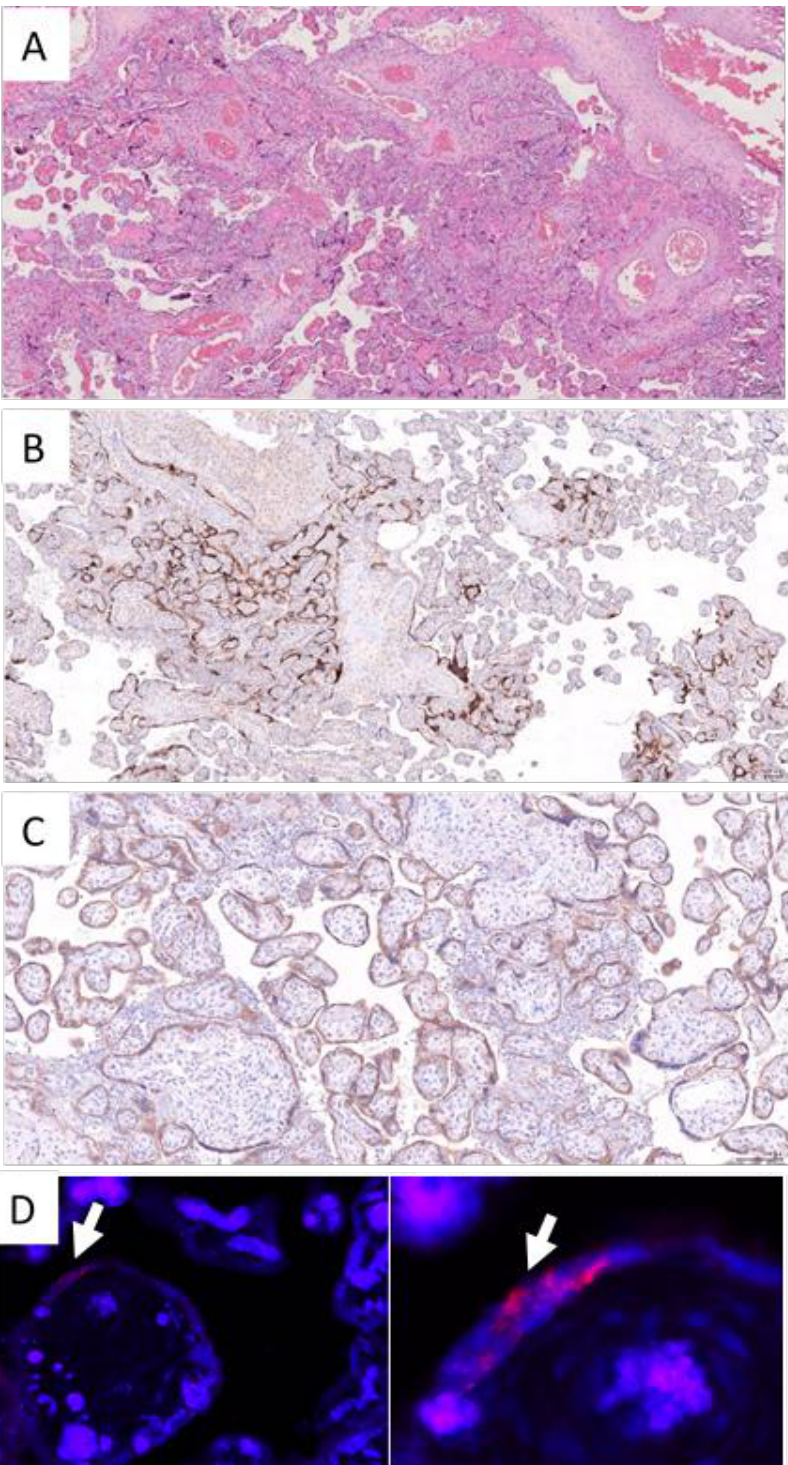
Figure 1. Placental examination—case 1. ( A ) Foci of chronic intervillositis with massive peri-villous fibrin deposition and early placental infarction (hematoxylin and eosin, original magnification ×4). ( B ) Strong cytoplasmic positivity of villous trophoblastic cells with SARS-CoV-2 spike antibody co-localized with the foci of chronic intervillous inflammation (hematoxylin and eosin, original magnification × 4). The following antibodies were used: CD68-PGM1 (Dako Monoclonal Mouse Anti- Human CD68, Clone PG-M1, dilution 1/200), ACE2 (Atlas antibodies, clone CL4035, dilution 1/1000), and SARS-CoV-2 spike antibody (Sino Biological, SARS-CoV Spike S1 Subunit Antibody, Rabbit PAb, Antigen Affinity Purified, dilution 1/250). ( C ) Diffuse and strong membranous ACE2